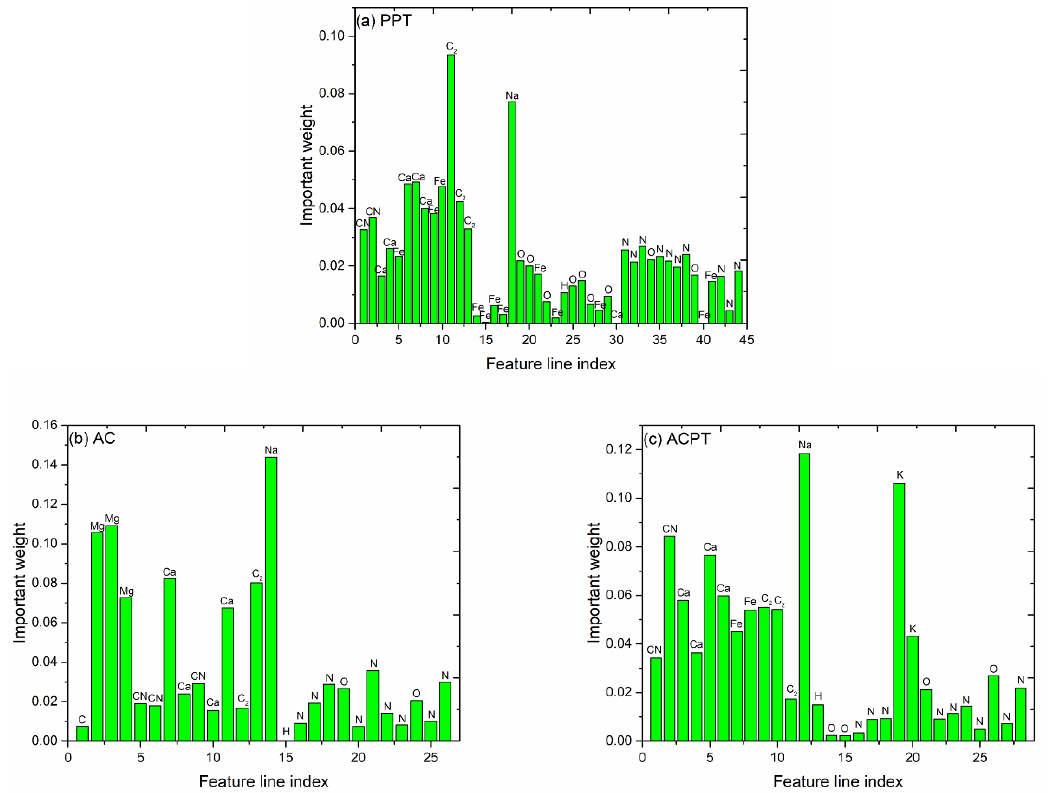
Figure 3. Importance of each ( a ) PPT, ( b ) AC and ( c ) ACPT spectral line for manufacturer identification based on the decrease in the Gini index of RF.